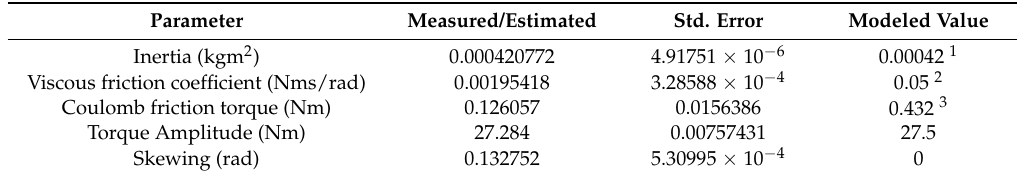
Table 4. Component design validation